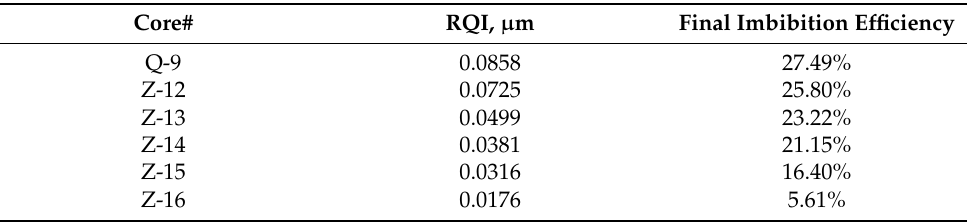
Table 2. Imbibition results for testing effects of the number index.